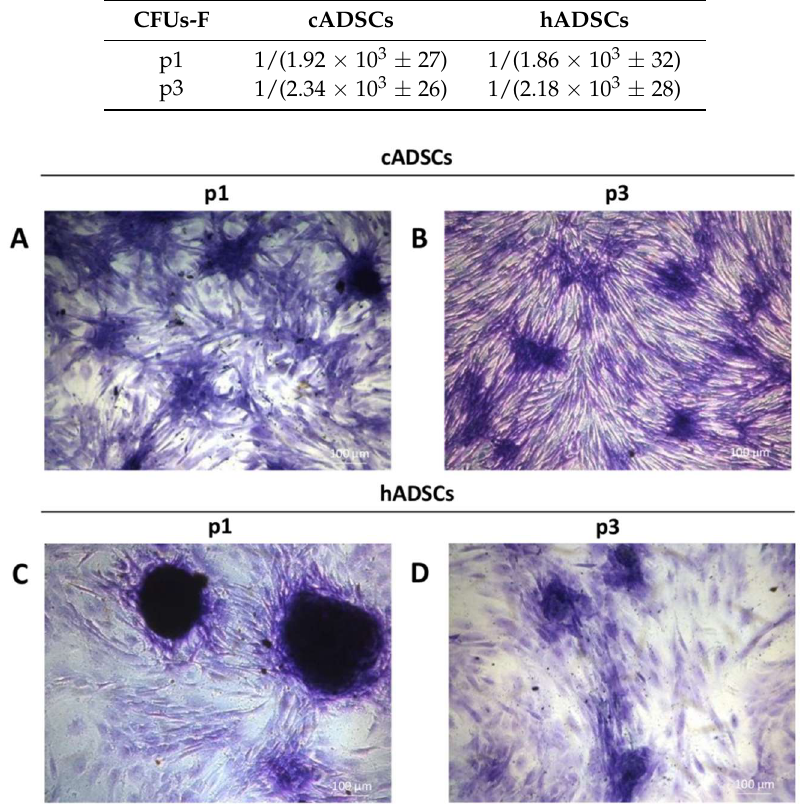
Table 2. Frequency of CFUs-F (mean ± SD) for cADSCs and hADSCs at different passages 144